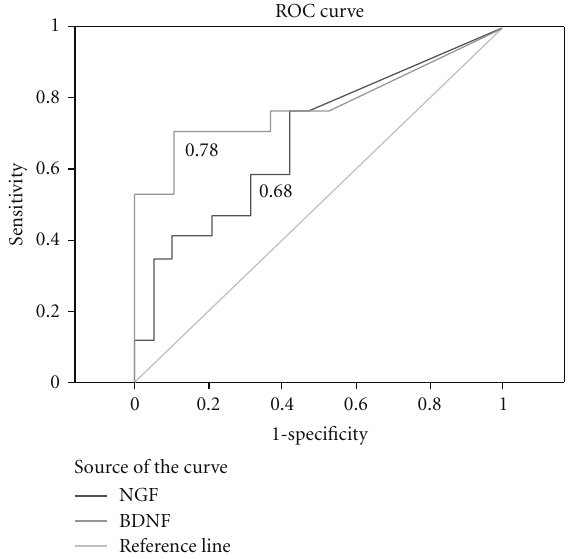
Figure 1: Receiver-operator characteristic (ROC) curves of urinary NGF/creatinine and urinary BDNF/creatinine in OAB patients. Notice that, for this cohort, BDNF has a better AUC than